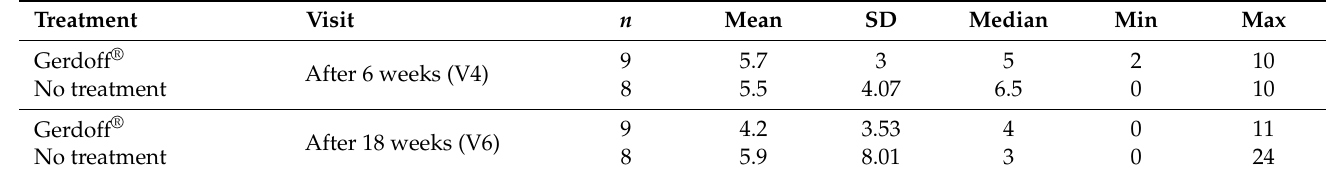
Table 4. Total RSI score results during the follow-up period.